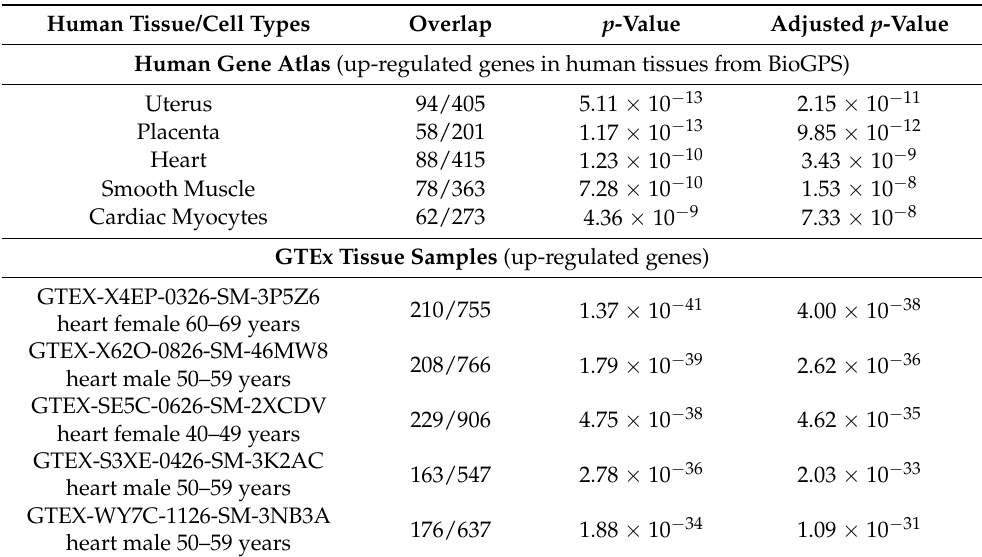
Table 2. Top 5 significantly enriched human gene atlas cell types and GTEx tissue samples in significantly upregulated CMs